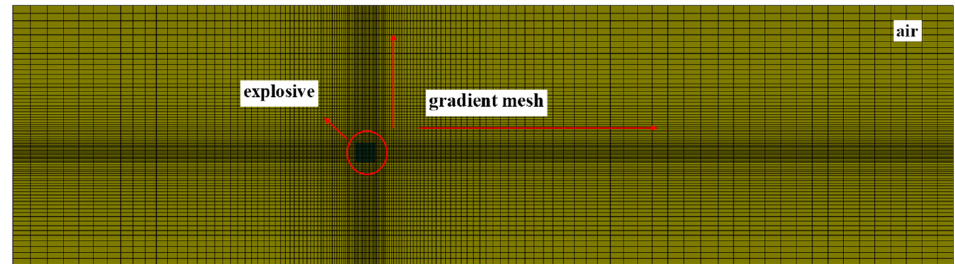
Figure 16. Model of air and explosive.